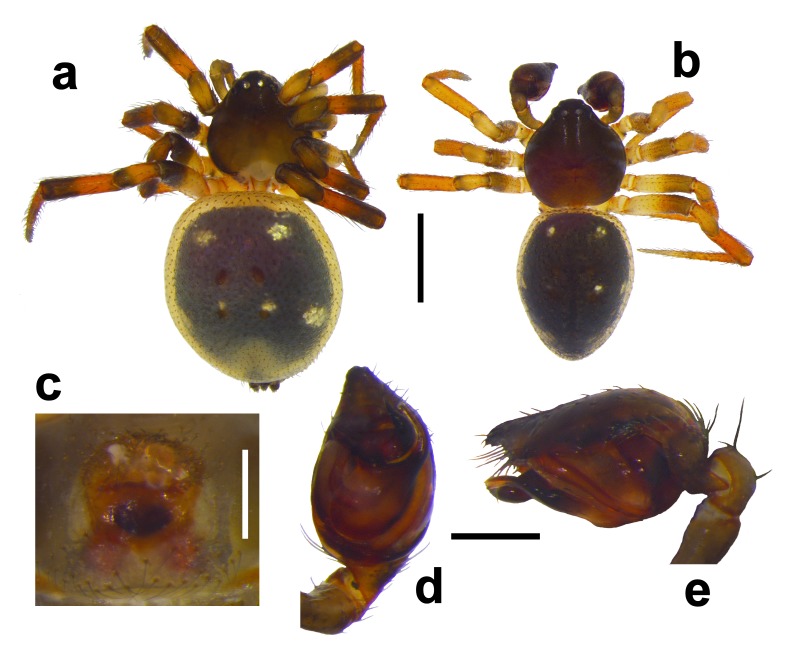
Euryopis
sexalbomaculata (Lucas, 1846). a: female, dorsal habitus, scale = 0.8 mm; b: male, dorsal habitus, scale = 0.8 mm; c: female epigynum, ventral, scale = 0.2 mm; d: left male palp, ventral, scale = 0.2 mm; e: left male palp, retrolateral, scale = 0.2 mm.